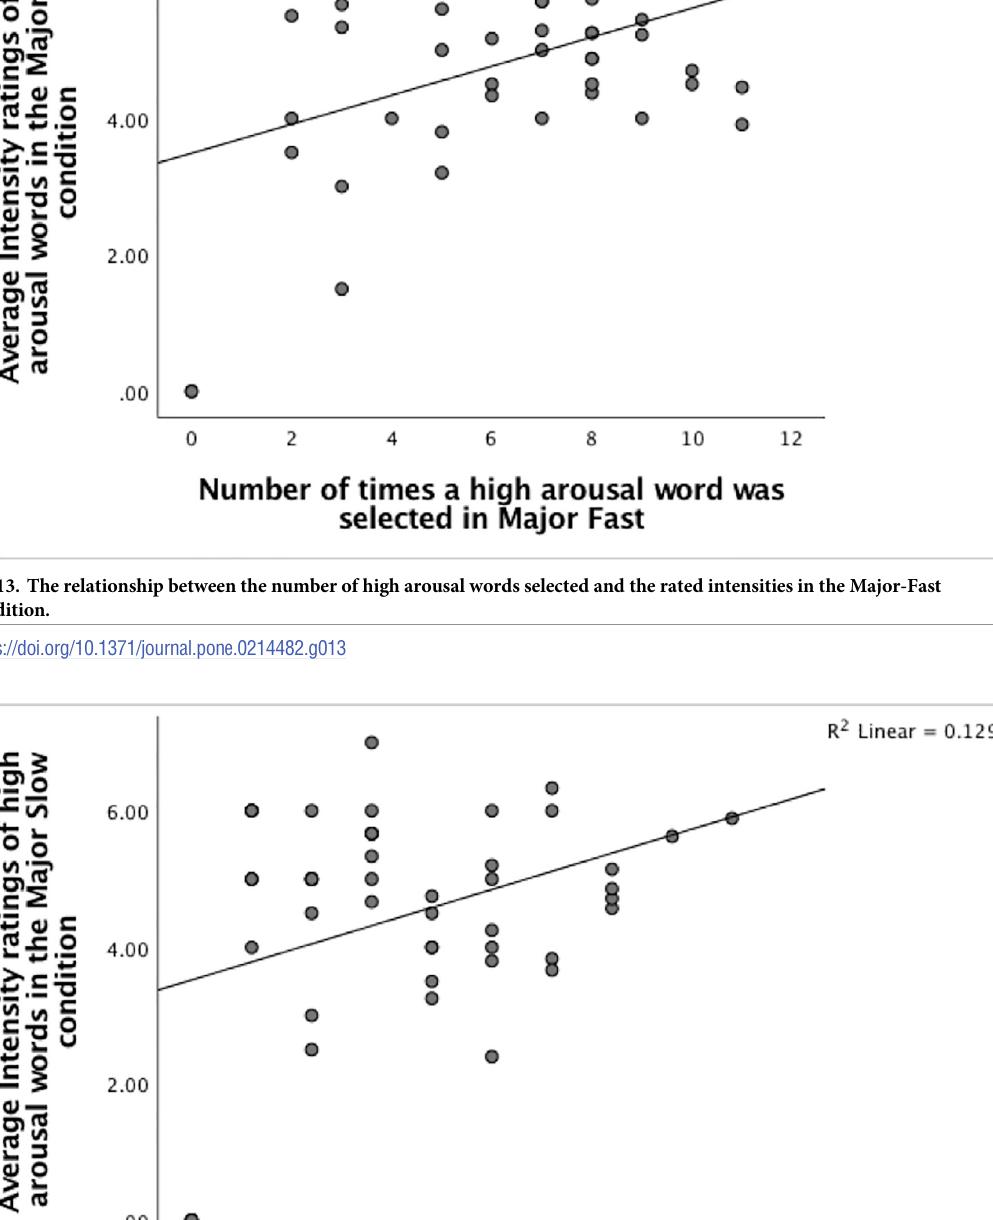
PLOS ONE | https://doi.org/10.1371/journal.pone.0214482 April 16,